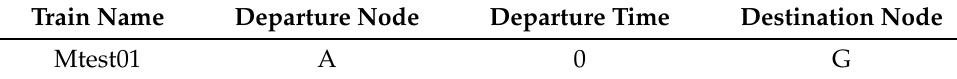
Table 3. Case 1: Train information.